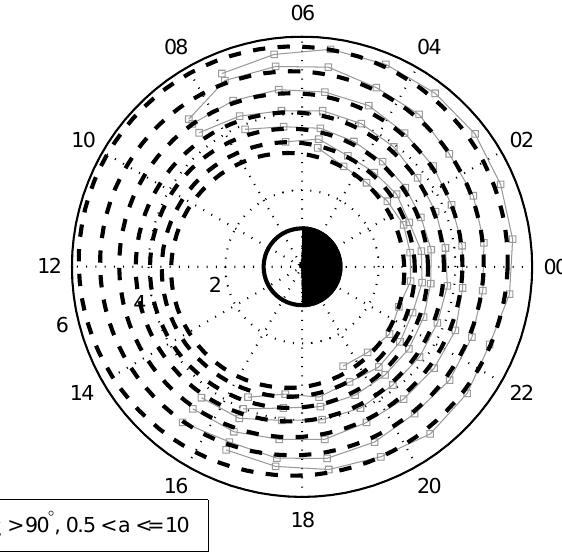
Fig. 9. Average model of the MSFAC boundary as a function of Kp (Kp=0.5, 1.5, 2.5, ... 6.5) and